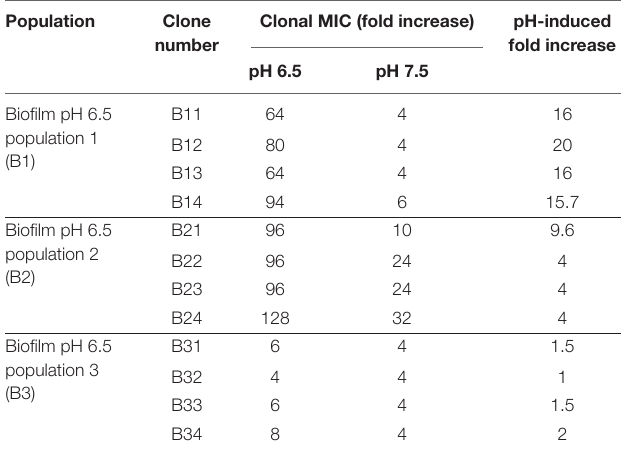
TABLE 1 | PA14 clonal MIC from the ceftazidime evolution study*. Population Clone Clonal MIC (fold increase) pH-induced number